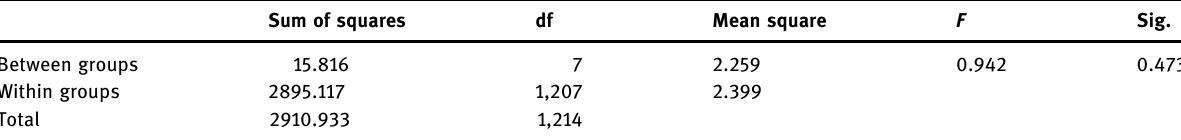
Table 14: Analysis of variance of knowledge level by areas of expertise of VHS Sum of squares df